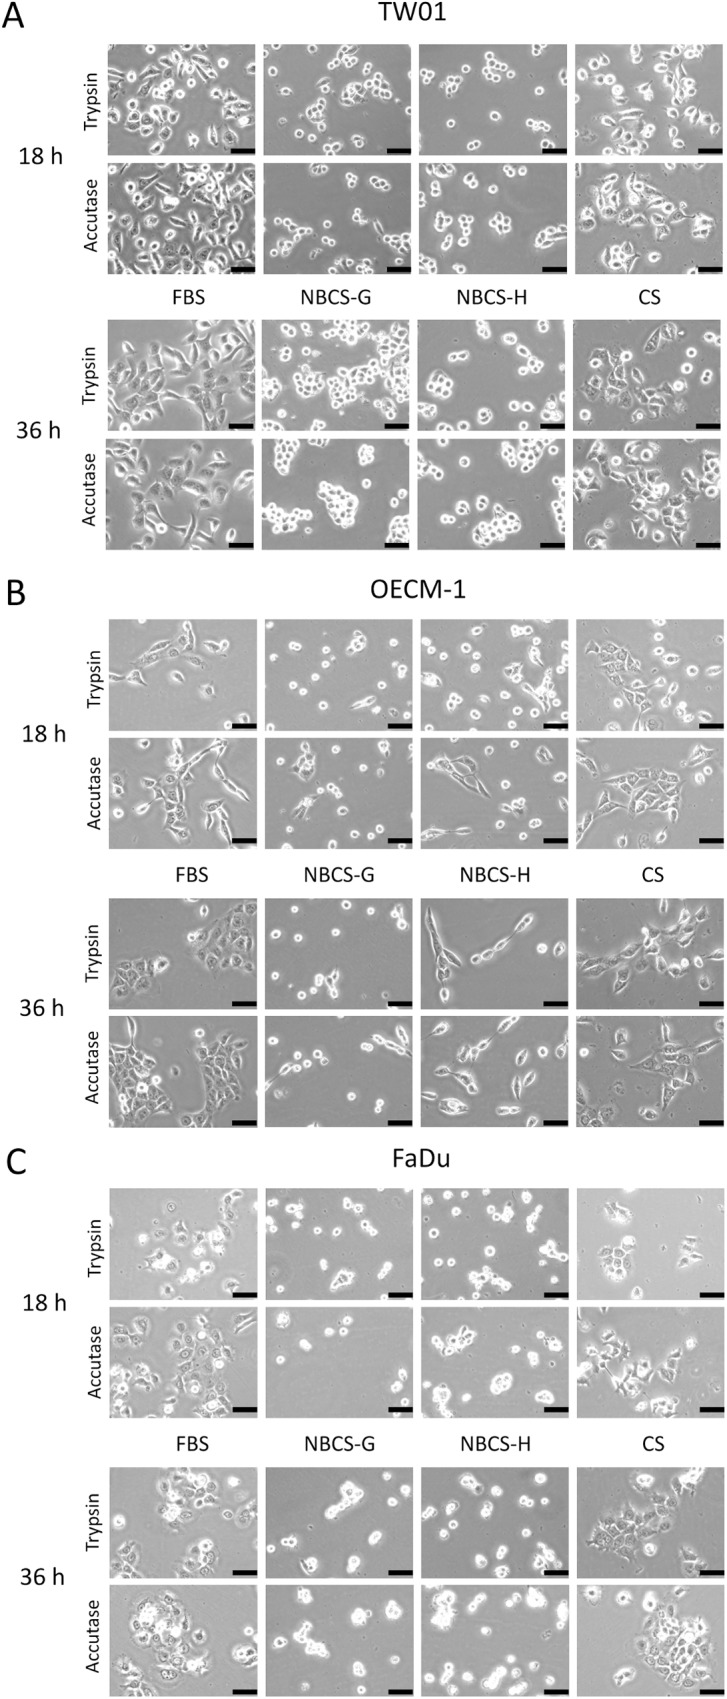
Morphology of cells cultured in FBS, NBCS, and CS.Cells were detached with trypsin (0.05%)-EDTA or Accutase and cultured in medium containing fetal bovine serum (FBS), newborn calf serum (NBCS), and bovine calf serum (CS). Cultured cells were photographed at 18 and 36 h after seeding. (A) TW01, (B) OECM-1, and (C) FaDu cells. Black bar represents 50 μm. NBCS-G: Gibco NBCS; NBCS-H: HyClone NBCS.